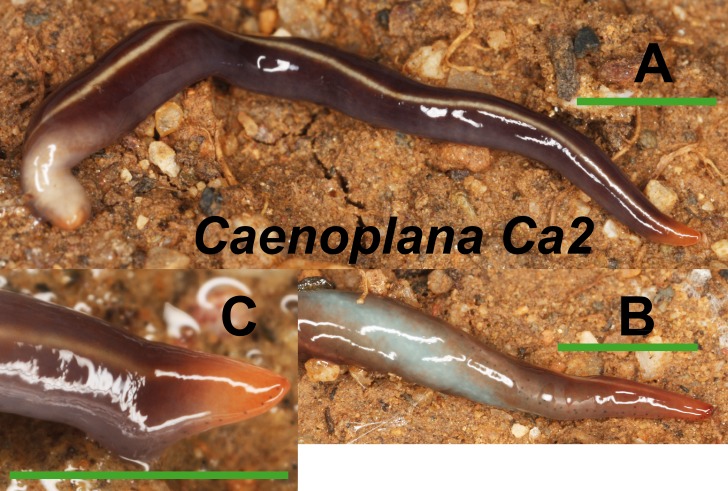
Caenoplana morph Ca2.(A) Dorsal view. (B) Ventral view of median part and dorsal view of anterior end showing line of eyes. (C) Lateral view of anterior end showing line of eyes. Scale bar 5 mm.